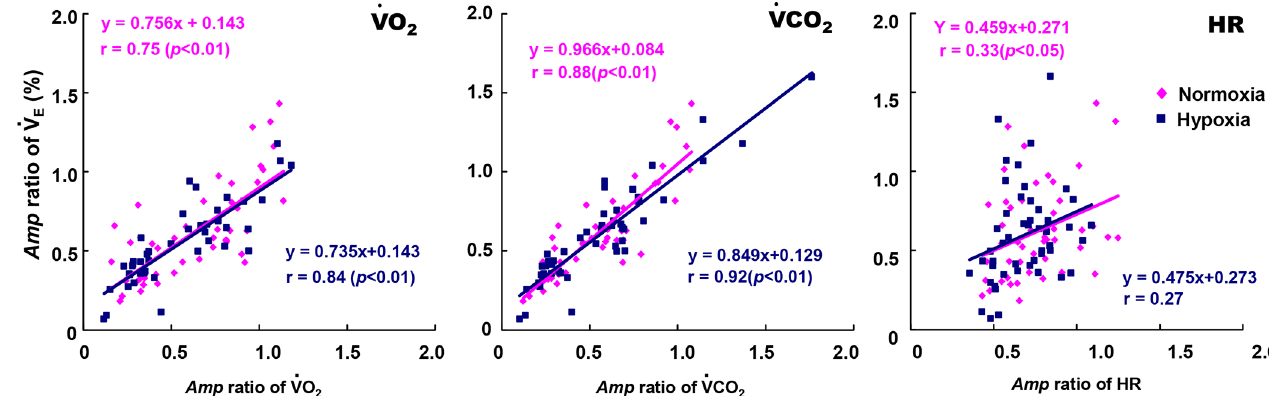
Fig 6. Relationship between the Amp ratio of gas exchange in hypoxia and normoxia. The Amp ratio of the _ V under conditions of either hypoxia or normoxia is shown. Note that the A ratio for the _ V In contrast, the Amp ratio for HR was not tightly related to the _ V between hypoxia and normoxia: for hypoxia, y = 0.85x + 0.13, r = 0.92 (p < 0.01); for normoxia, y = 0.97x + 0.08, r = 0.88 (p <